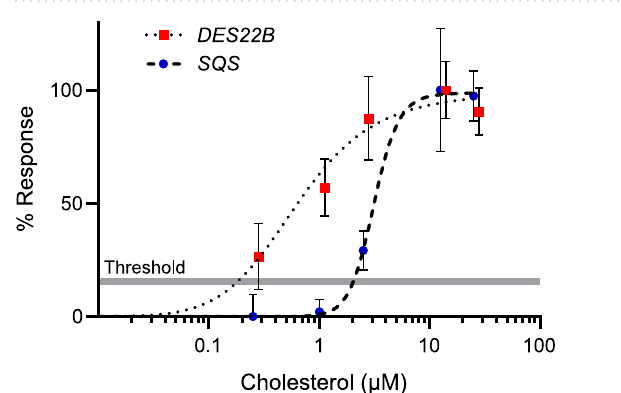
Figure 3. Effects of Cytochalasin D on the expression of cholesterol-regulated genes in wild - type (CU428) and phagocytosis-deficient (II8G-IA) strains. Cultures at exponential growth phase were incubated with 2 μM Cytochalasin D (CytD) or vehicle for 30 min prior to the addition of 26 μM cholesterol. Total RNA was extracted after 1 h of treatment with cholesterol and gene expression was analyzed by RT-qPCR. Data are expressed as mean ± SD (n = 3) log 2 fold change relative to untreated cells of the respective strain. * p < 0.05 vs. untreated cells; # p < 0.05; ns, not significant difference; One-way ANOVA with Tukey post hoc test.